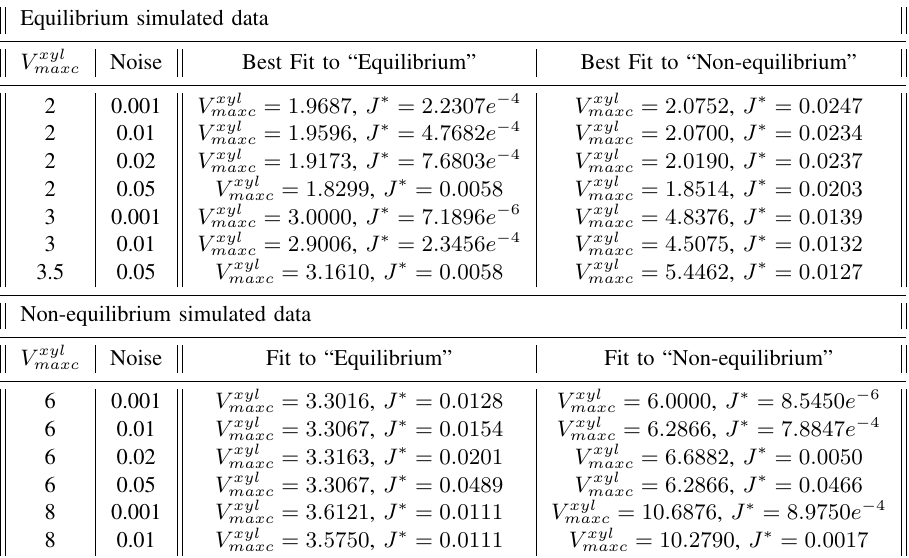
O PTIMAL COST USING SIMULATED DATA FOR THE CONCENTRATION OF XYLENE IN VENOUS BLOOD . T HE V xyl maxc VALUE USED FOR SIMULATION IS LISTED IN COLUMN 1 OF THE TABLE , AND INITIAL GUESSES FOR V xyl maxc FOR THE OPTIMIZATION ROUTINE WERE 3, 6, AND 10. T HE VALUE FOR J ∗ THAT WAS LOWEST FOR THE THREE IS LISTED BELOW